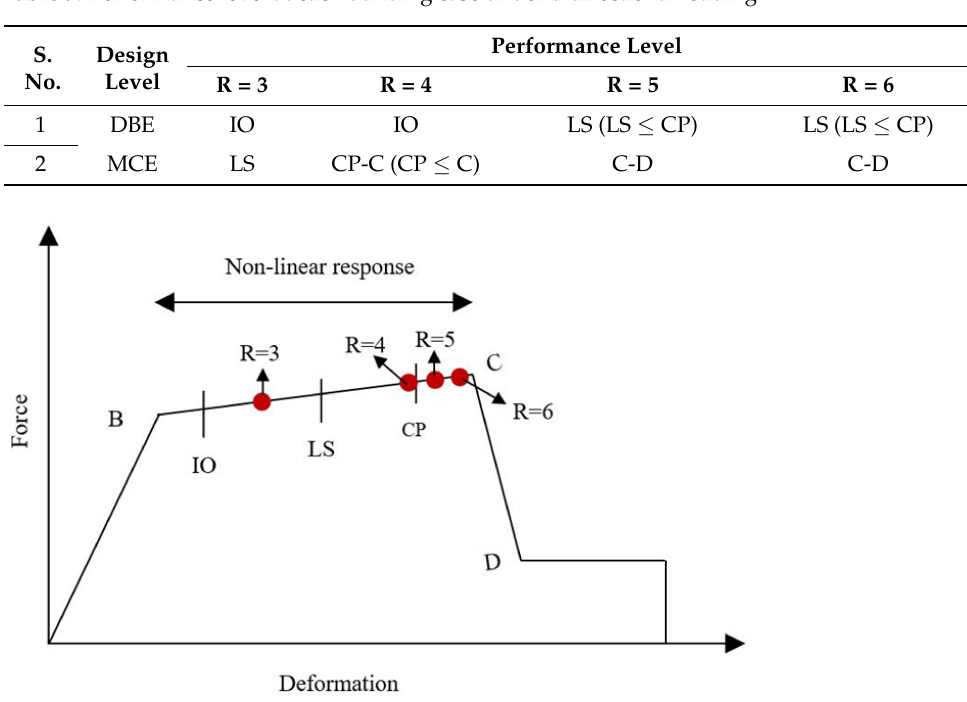
Table 9. Performance level at each building case under bidirectional loading.